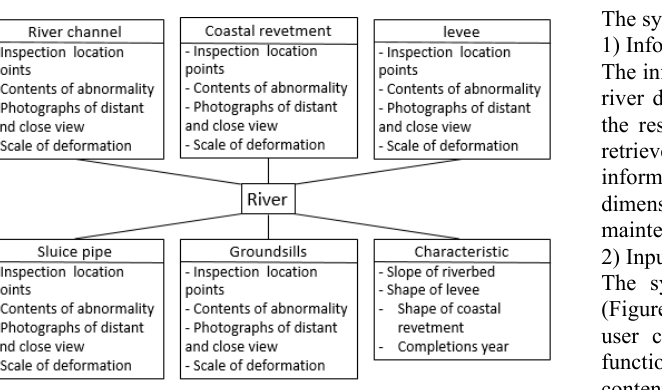
Figure 8. System architecture